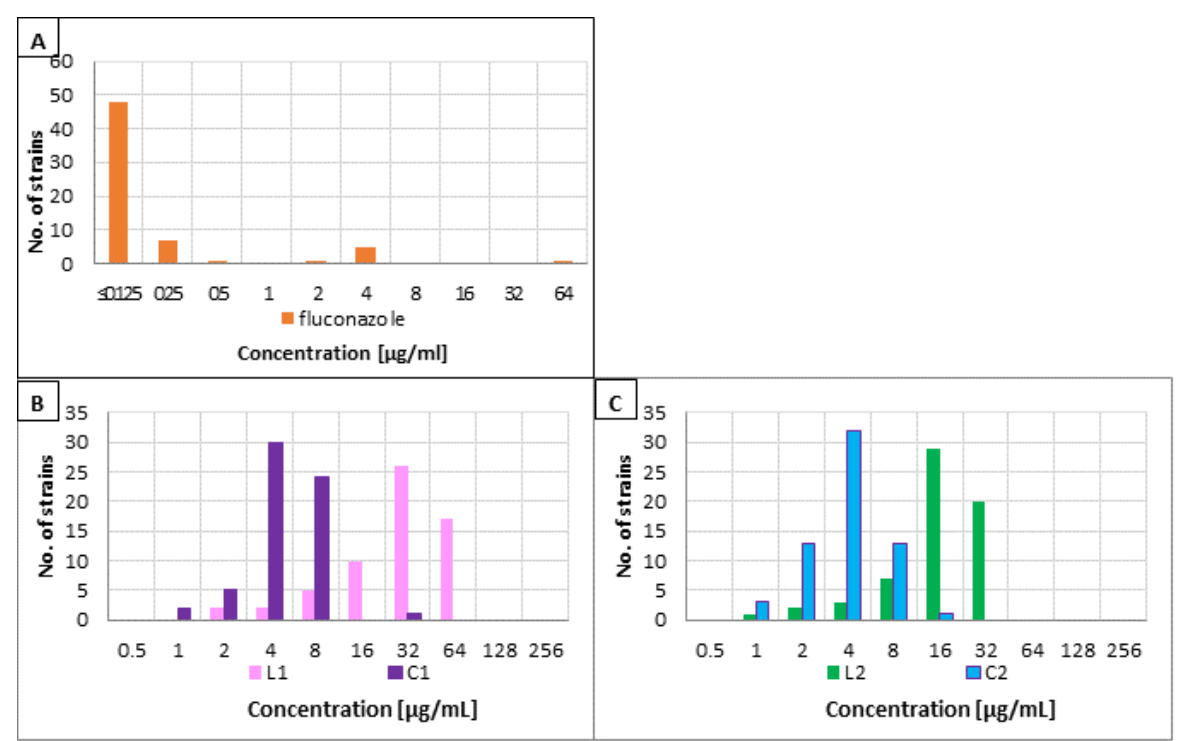
Figure 1. MIC value distribution of the tested compounds: ( A ) fluconazole, ( B ) lipopeptides L1 and C1, and ( C ) lipopeptides L2 and C2.